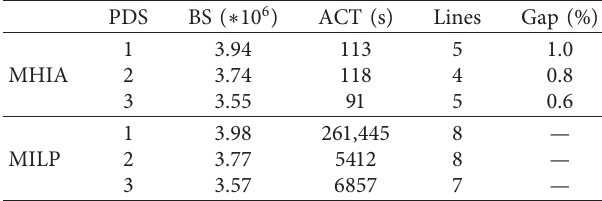
Table 10: Results of MHIA and MILP (with a given line pool) for the small HSR